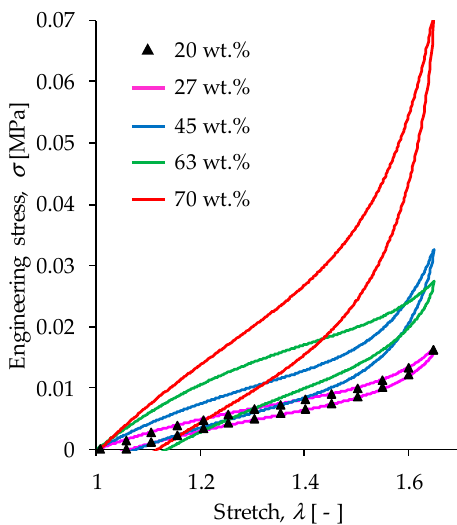
Figure 20. Theoretical predictions computed by using Equations (10) and (12) for different wt % of carbonyl iron particles added to the PDMS elastomeric matrix material under the action of a magnetic flux density of 52.2 mT. For the material samples with 20 and 27 wt % of CIPs, the mechanical response due to the magnetic flux intensity and applied load is almost the same because the volumetric fraction of CIPs used to develop the MRE material is almost the same, as illustrated in Table 1. As expected, the MRE samples developed by using 70 wt % of CIPs exhibit the highest shear modulus, dissipation energy, and engineering stress values. These results agree with rheological tests discussed in Section 4.6. Table 1. Material constants used to fit the cyclic experimental data. Applied magnetic flux density of 𝐵 = 52.2 mT , with a magnetic permeability of 𝜇 = 𝜇 (cid:3045) 𝜇 (cid:2868) , and vacuum magnetic permeability equals ( 7) μ π − = Notice that there is a linear relationship between the wt % of CIPs versus the to 0 4 10 H/m. magnetic permeability values. N 8 CIPs wt % G (MPa)